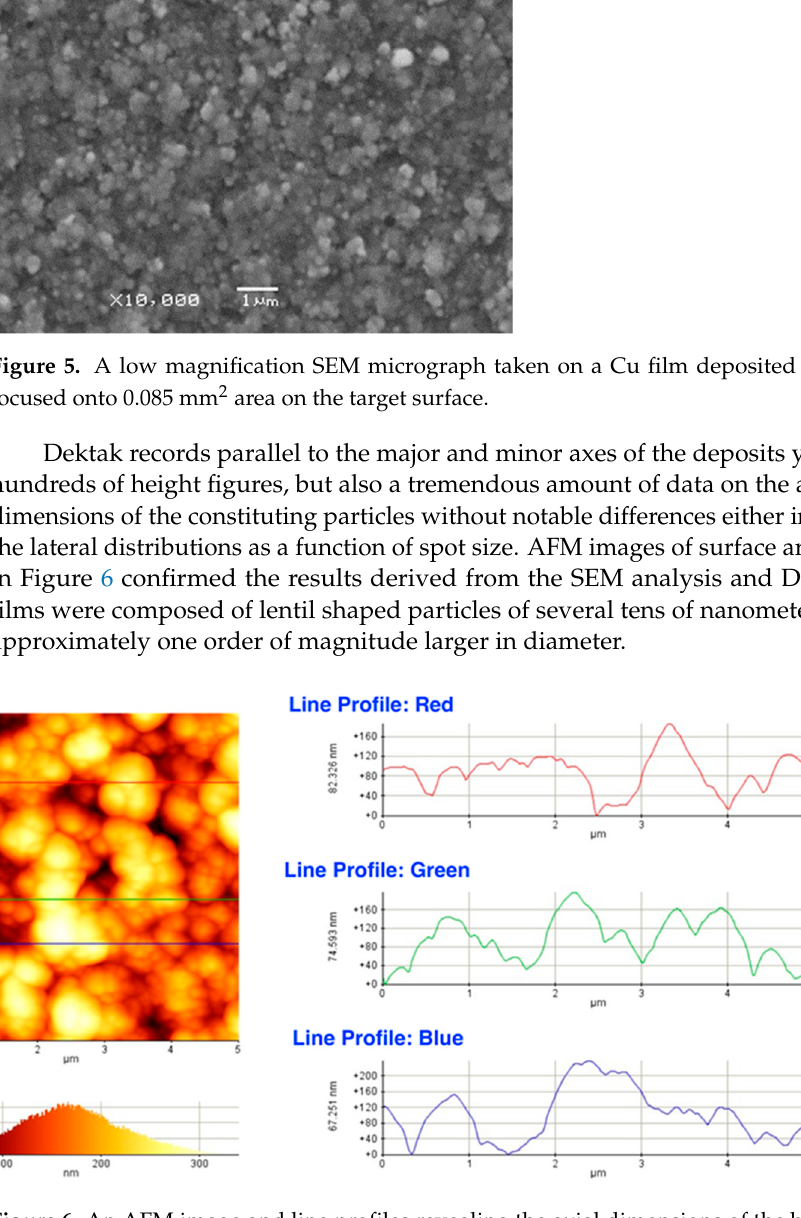
Figure 6. An AFM image and line profiles revealing the axial dimensions of the building blocks of the films.